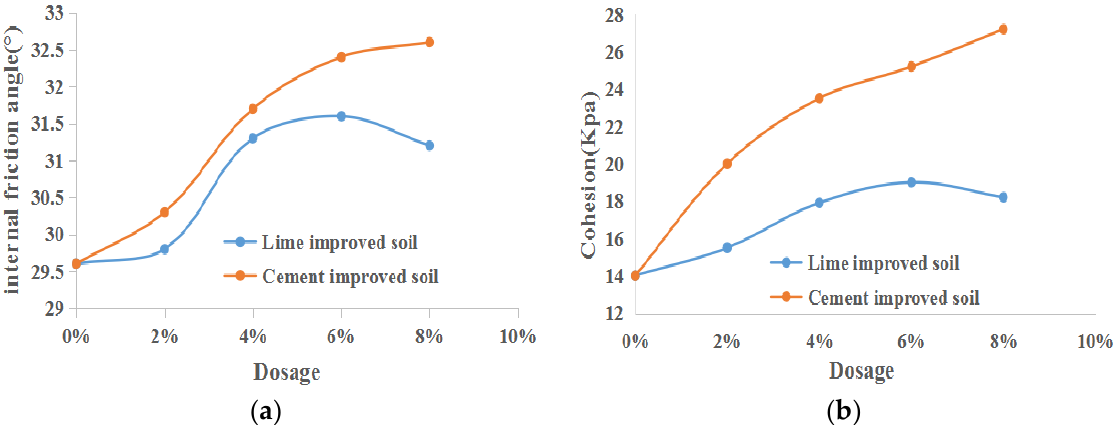
Figure 4. Variation curves of the internal friction angle and cohesion of the improved soil with the content. ( a ) internal friction angle, ( b ) cohesion.